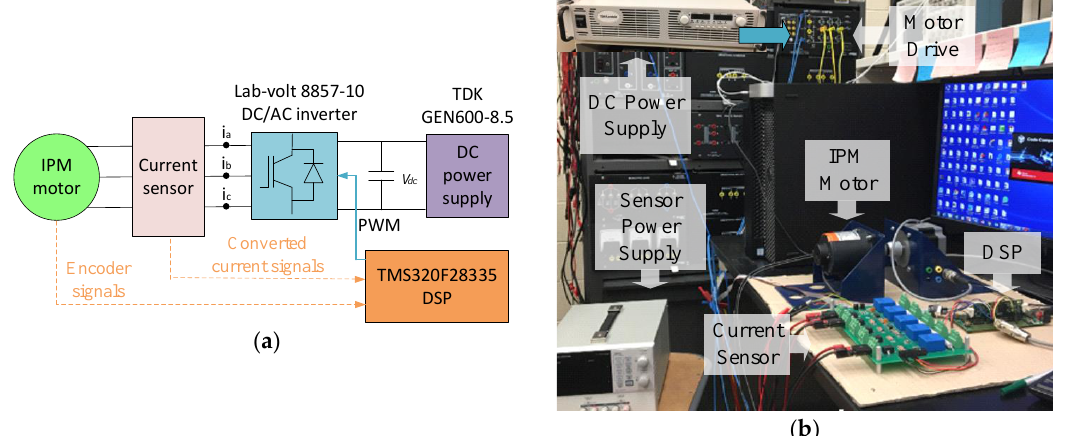
Figure 5. Building a hardware experiment system for digital signal processor (DSP)-based microcontroller. ( a ) Experiment schematic; and, ( b ) Experiment setup.